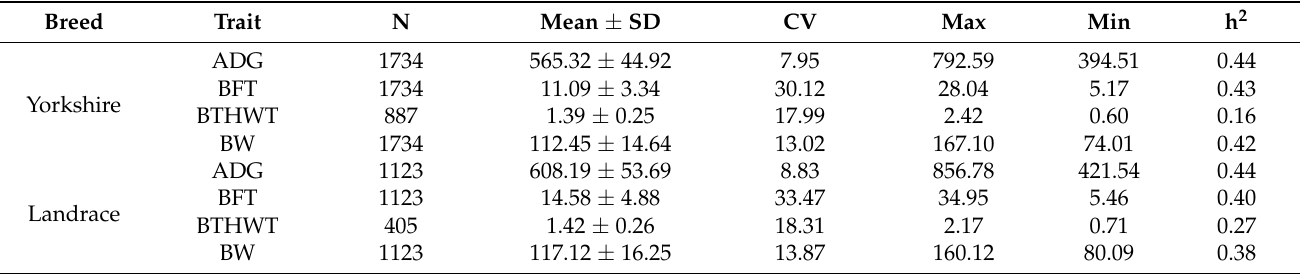
Table 1. Phenotypic statistics and SNP chip-based heritability estimations for four growth-related traits in two breeds.